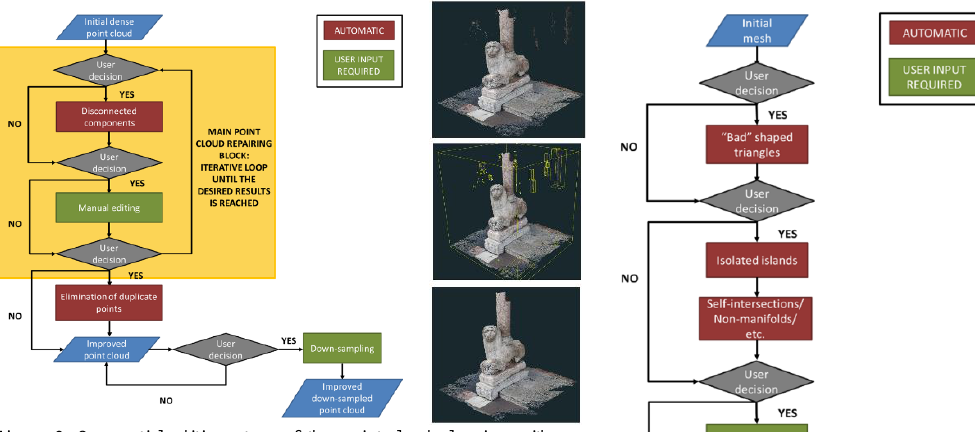
Figure 6: Sequential editing steps of the point cloud cleaning with examples.